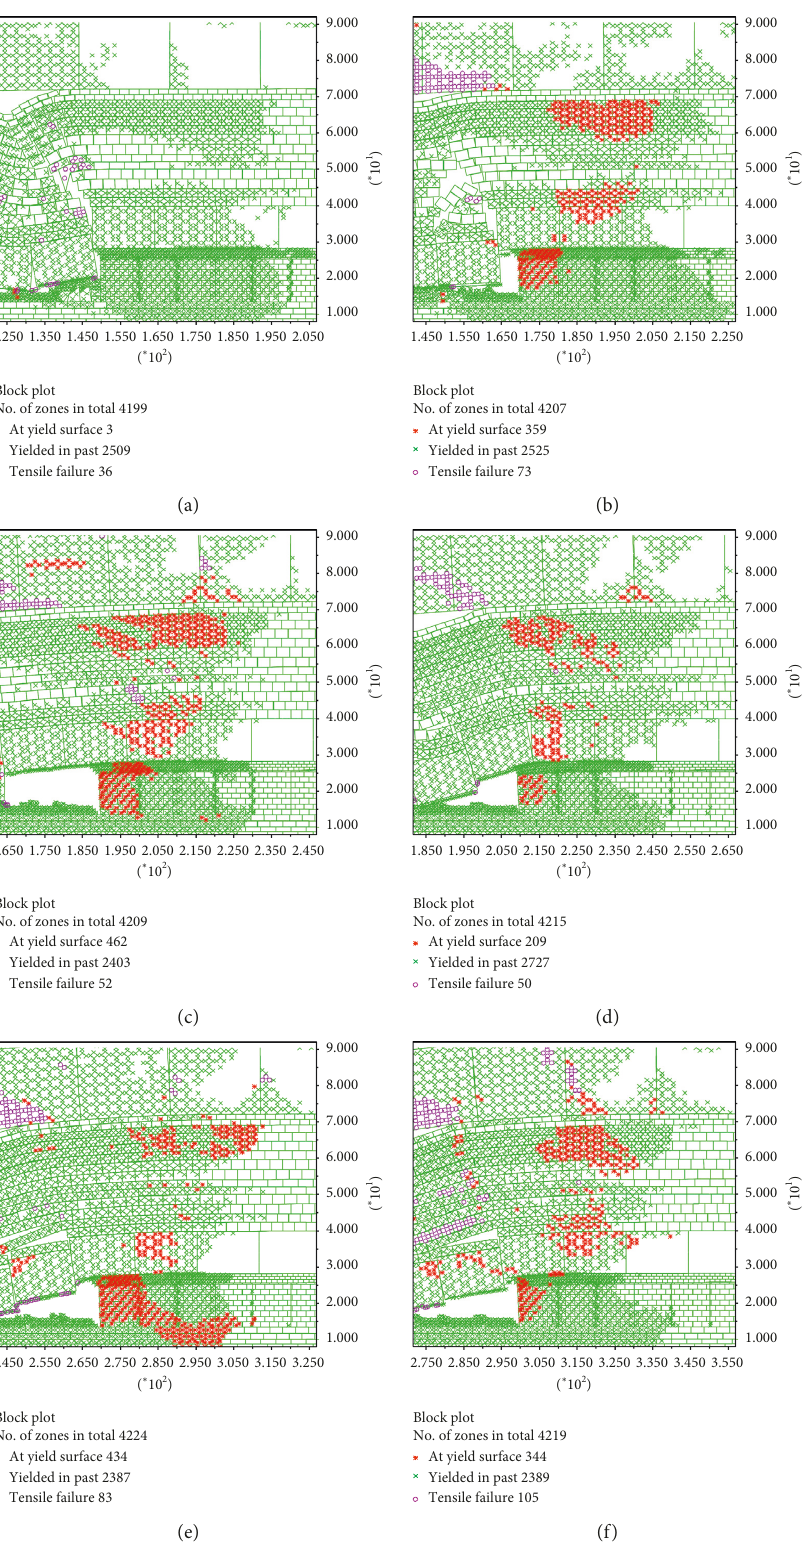
Figure 6: The plastic zone distribution of surrounding rocks in the working face under different advance distances of the working face. (a) 50 m. (b) 70 m. (c) 90 m. (d) 110 m. (e) 150 m. (f) 200